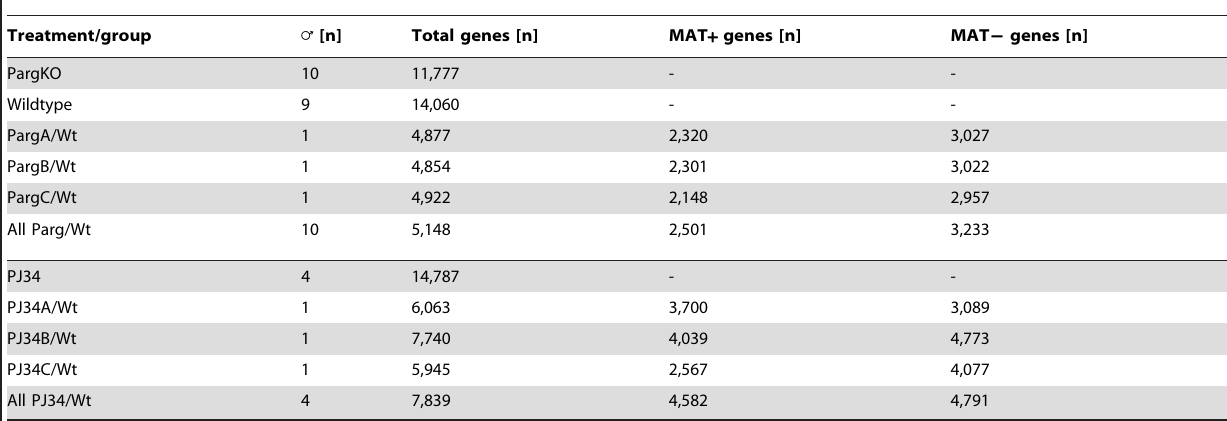
Table 1. Genes associated with